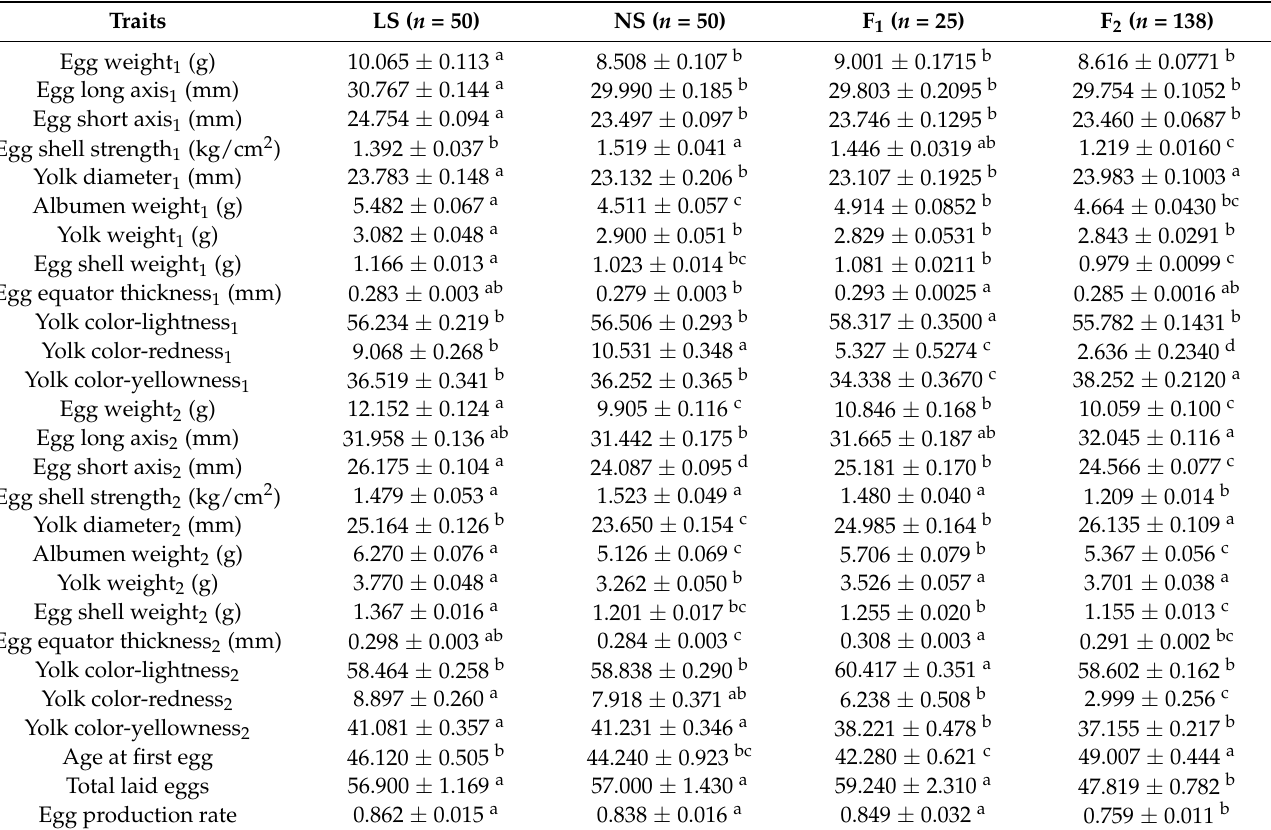
Table 1. Egg-related traits (mean ± standard error) used in this